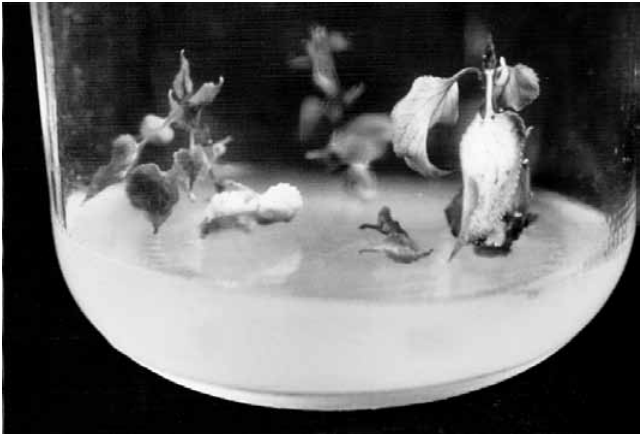
Means within a column or a row followed by the same letter(s) are not significantly different at the 0.05 level of probability.